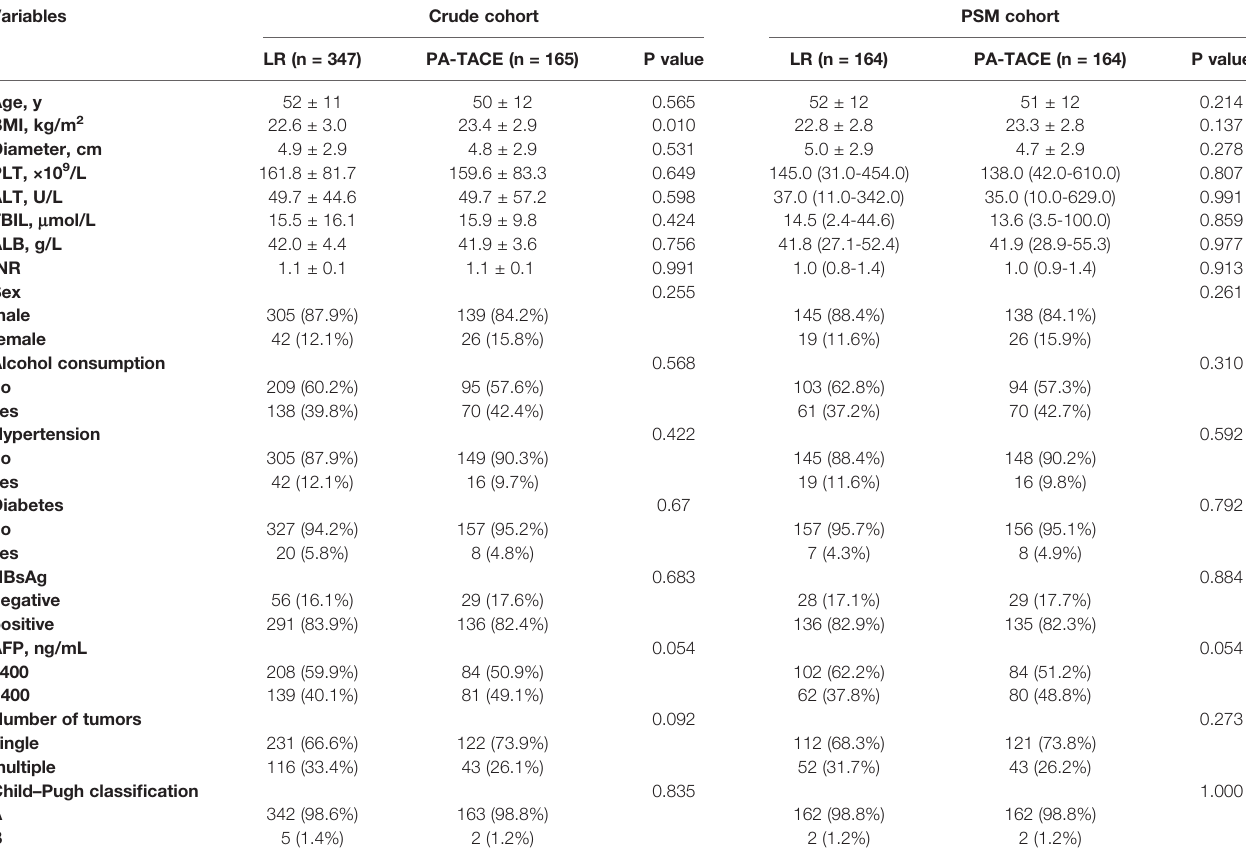
TABLE 1 | Baseline data of all patients strati fi ed by treatment.